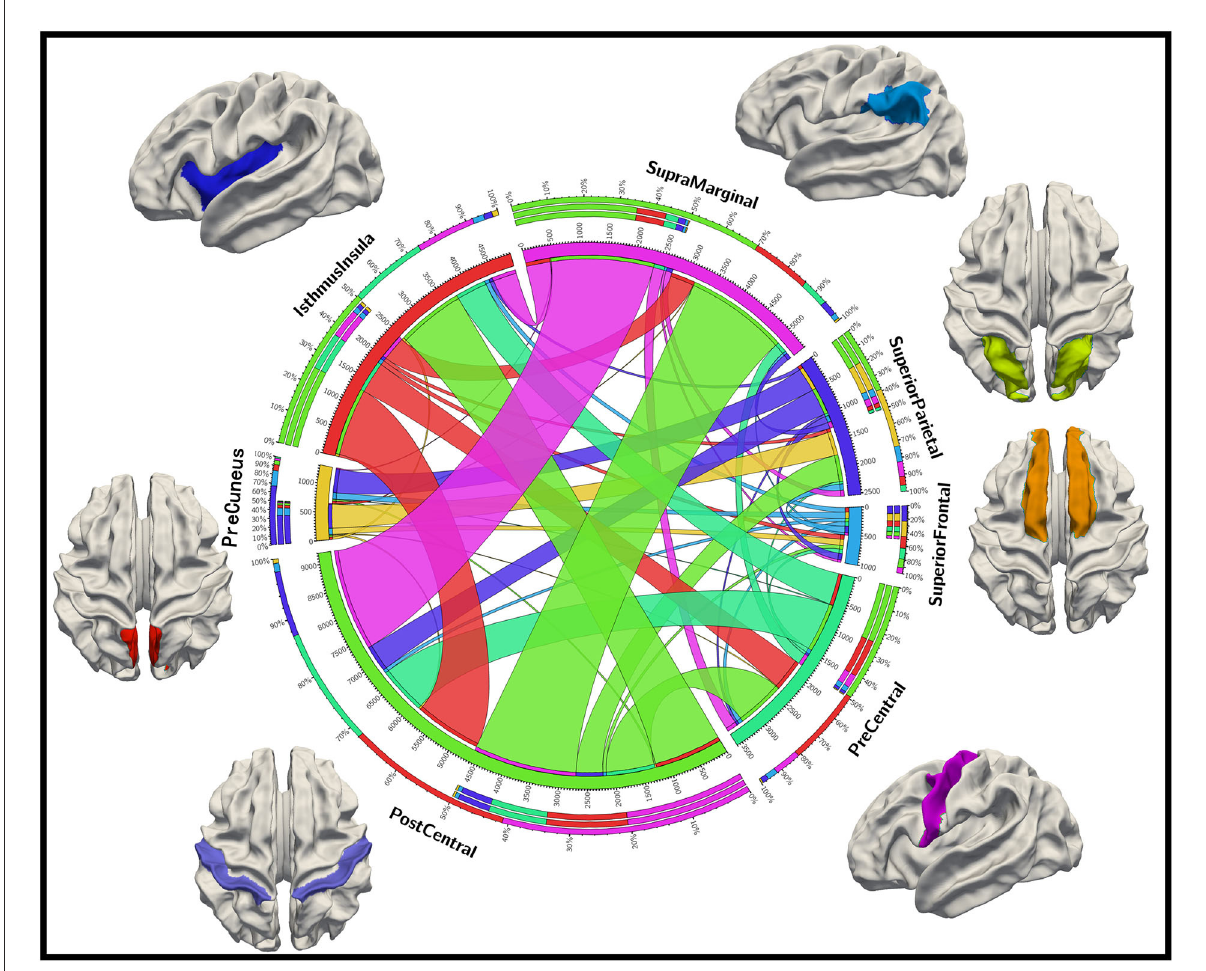
FIGURE6 Structural connection patterns among important brain regions.